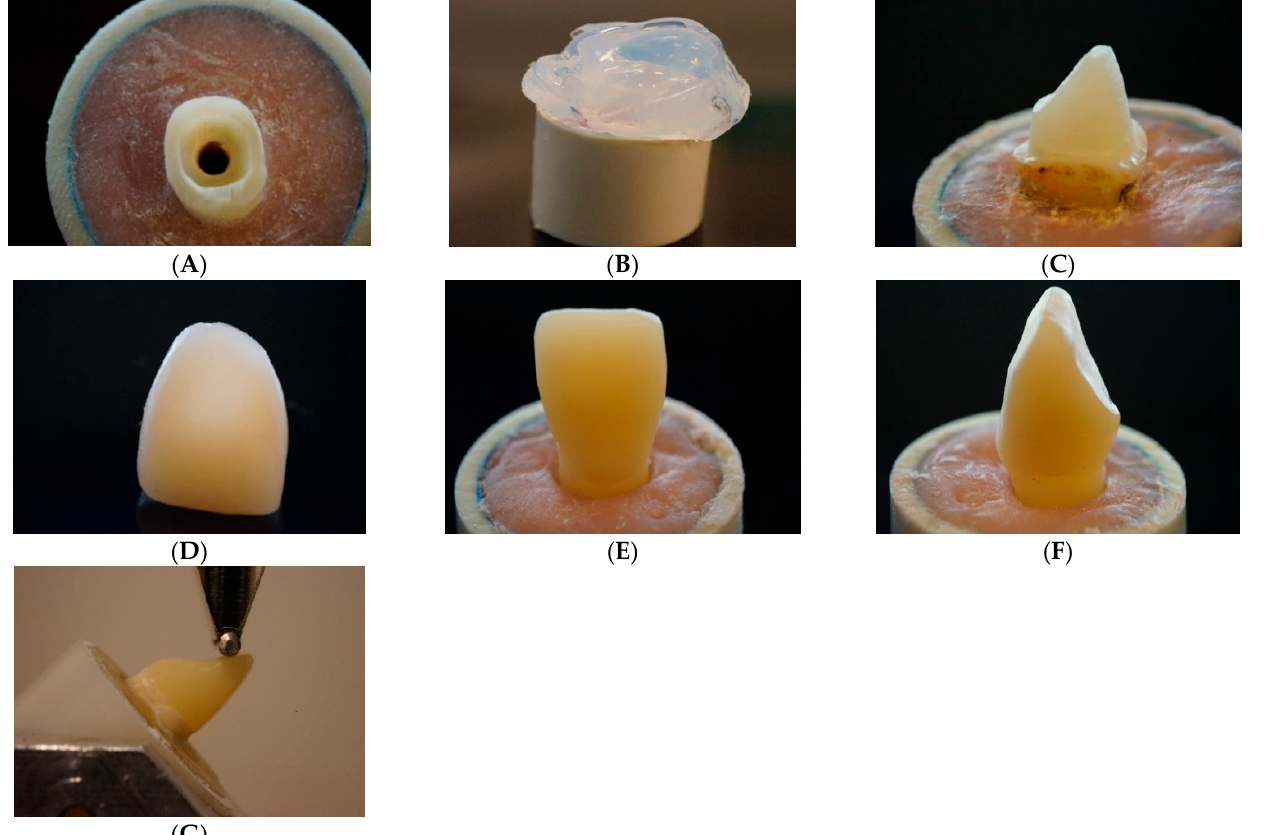
Figure 1. ( A ): tooth preparation, ( B ): transparent template mold for composite build-up, ( C ): post and core restoration, Figure 1. ( A ) tooth preparation, ( B ) transparent template mold for composite build-up, ( C ) post and core restoration, ( D ): crown fabrication, ( E , F ): labial and proximal views of final crown restoration, ( G ): inclined quasistatic-load test setup. ( D ) crown fabrication, ( E , F ) labial and proximal views of final crown restoration, ( G ) inclined quasistatic-load test setup. Next, post-core and crowns were made based on four different restorative approaches (Figure 2) subdivided into 10 groups ( n = 10/group), presented in Table 2. A total of ten sound teeth were left as control specimens (Group